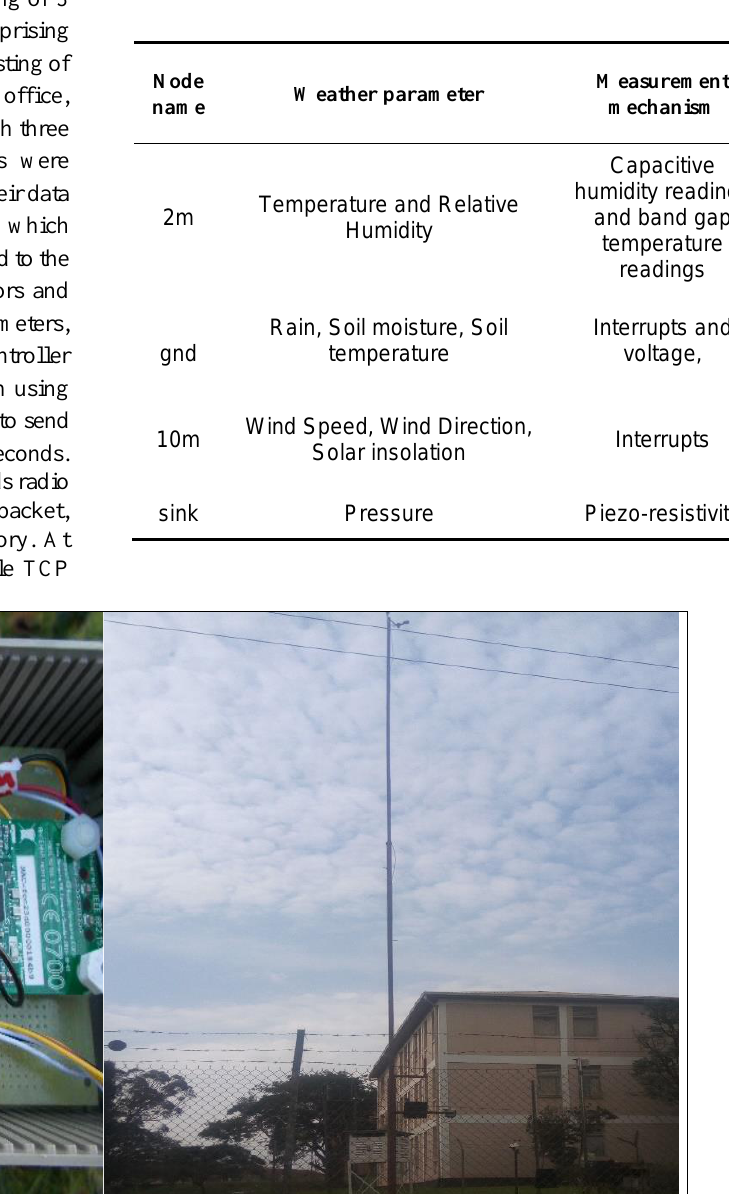
Table 2 . Weather parameters and nodes used